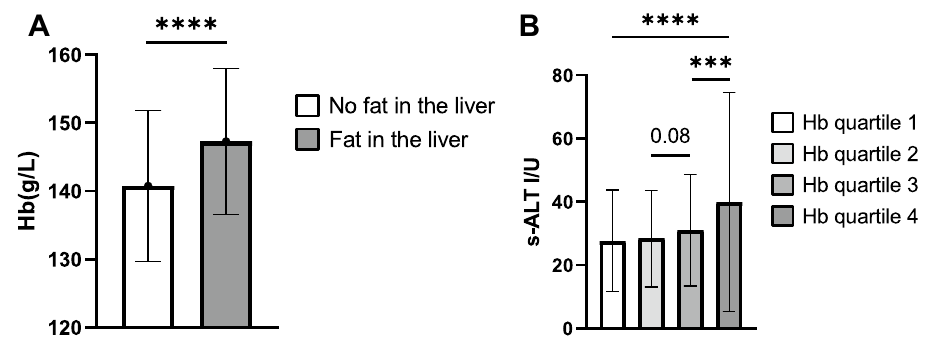
Figure 2. Association of Hb levels with fatty liver disease. ( A ) Hb levels of the subjects with no liver fat accumulation (n = 697) and subjects with liver fat accumulation (n = 256) at baseline. ( B ) Baseline mean ± SD of serum alanine aminotransferase (s-ALT) levels for the corresponding Hb quartiles. Hb quartile 1 has the lowest Hb and Hb quartile 4 the highest Hb levels. For S-ALT analysis was adjusted for smoking, alcohol consumption and BMI. Hb hemoglobin.